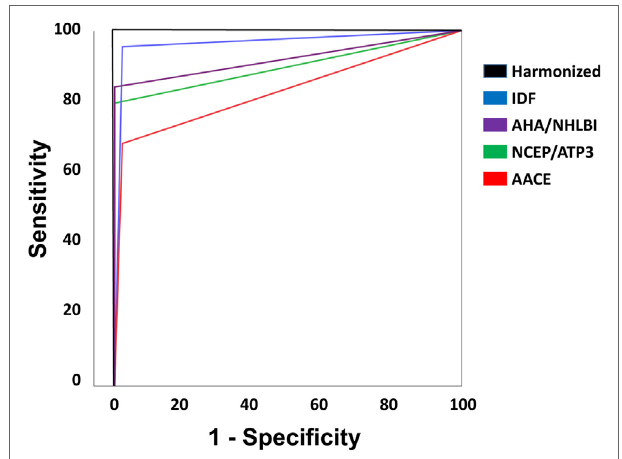
FigUre 3 | Receiver operating characteristic curve for all criteria studied. Statistical analysis comparing all area under curve (AUC) with the AUC for harmonized criterion, used as reference. AUC for International Diabetes Federation (IDF) criterion was 0.966, and it was not different from AUC of harmonized criterion ( p = 0.092). On the other hand, the use of the other three criteria for MetS resulted in significantly lower performance, with AUC for AHA/NHLBI = 0.920 ( p = 0.0147), NCEP/ATP3 = 0.898 ( p = 0.0067), American Association of Clinical Endocrinologists (AACE) = 0.830 ( p = 0.00059) when compared with harmonized